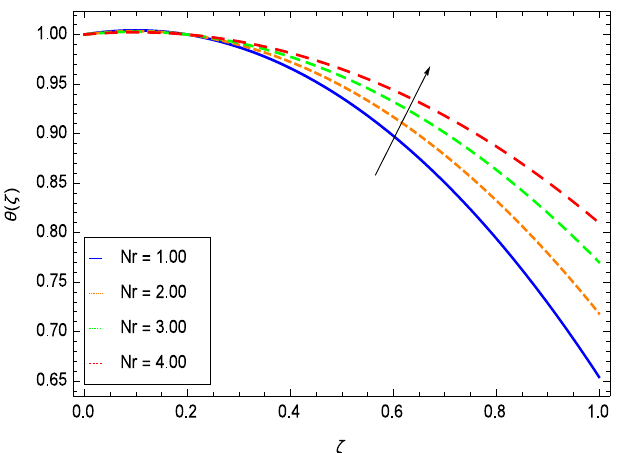
Figure 17. Conduction layer at h = − 3.00, β = 0.10, φ = 0.40, n = 1.50, S = 0.50, M = 2.00, Pr = 10.00, A 3 = A 4 = 0.20, We = 0.50, A = π with the enhancement in Nr . 4